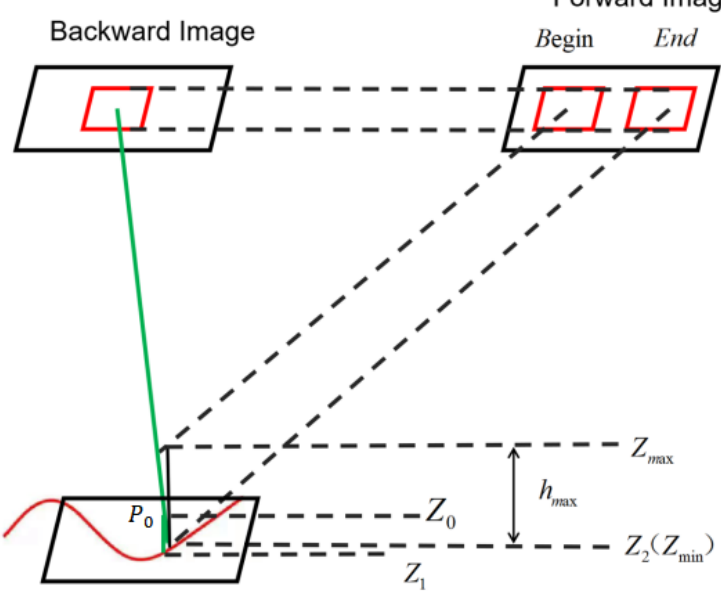
Figure 2. The principle of parallex search range